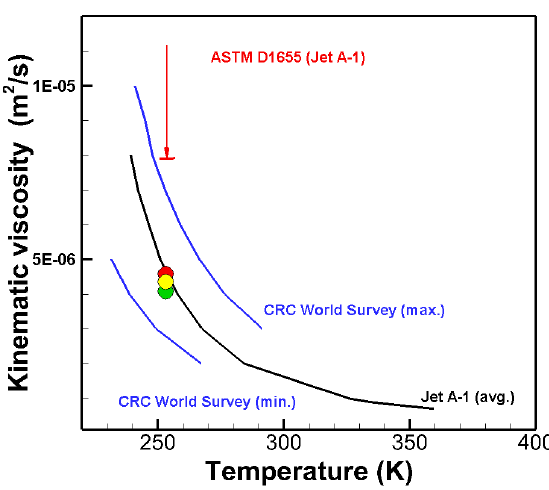
Figure 13. Same as in Figure 12 but for the kinematic viscosity, data from [43].